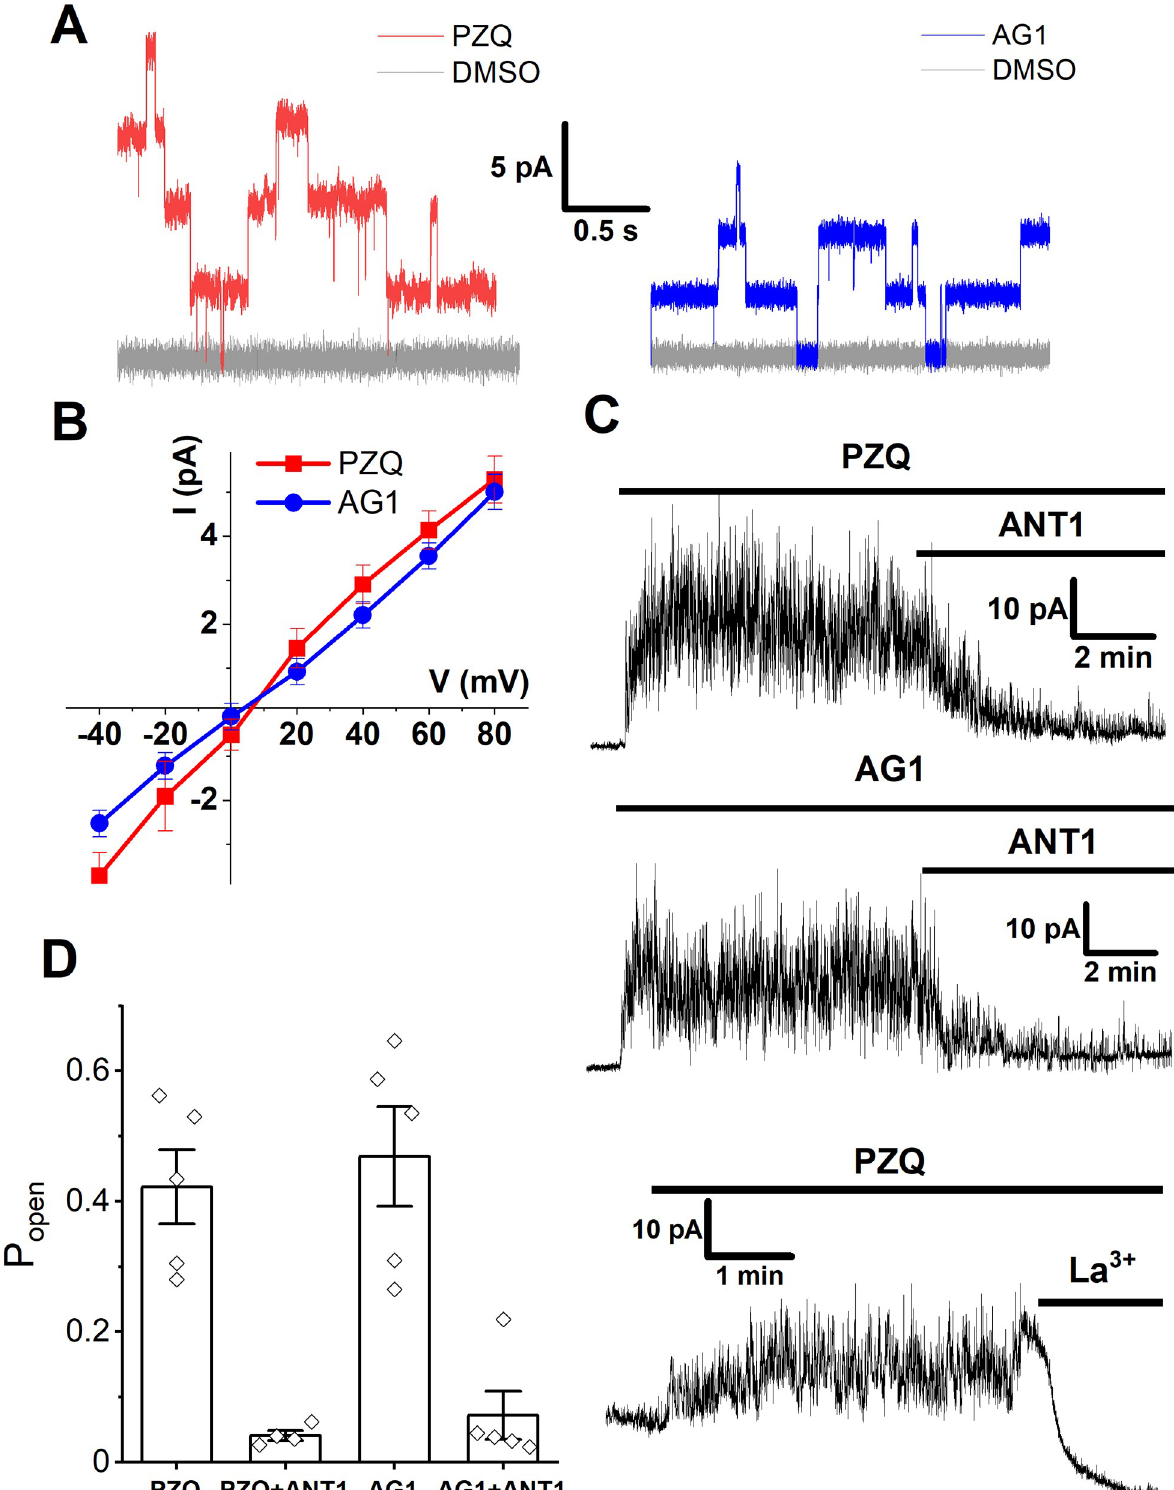
Fig 5. Electrophysiological analysis of new Sm .TRPM PZQ chemotypes. ( A ) Sm .TRPM PZQ channel fluctuations evoked by PZQ (red) or AG1 (blue) both applied at 10 μ M compared to vehicle responses (grey, 0.1% DMSO). Recordings were made in Ca 2+ -free solution at a clamping potential of +60mV in an inside-out configuration. DMSO and the test drug (PZQ or AG1) were added sequentially to the same patch. ( B ) Current